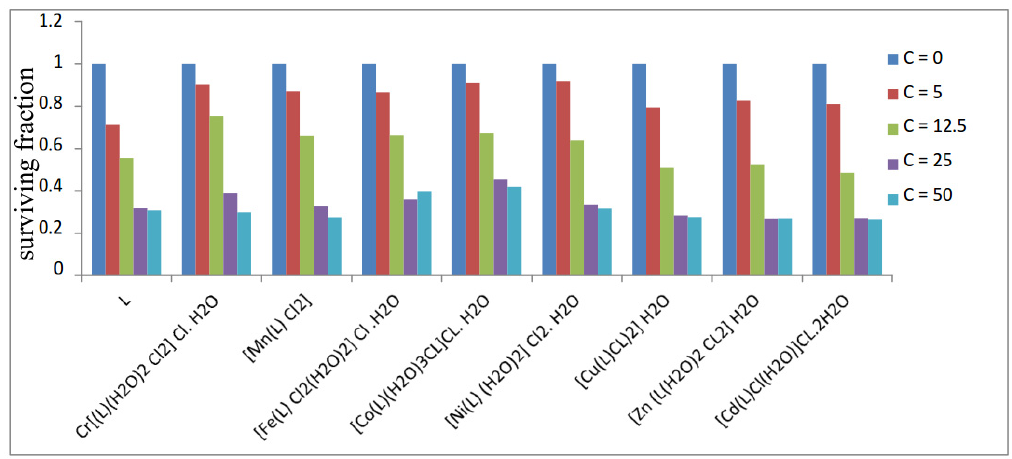
Figure 6. Anticancer activity of Schiff base ligand and its metal complexes .